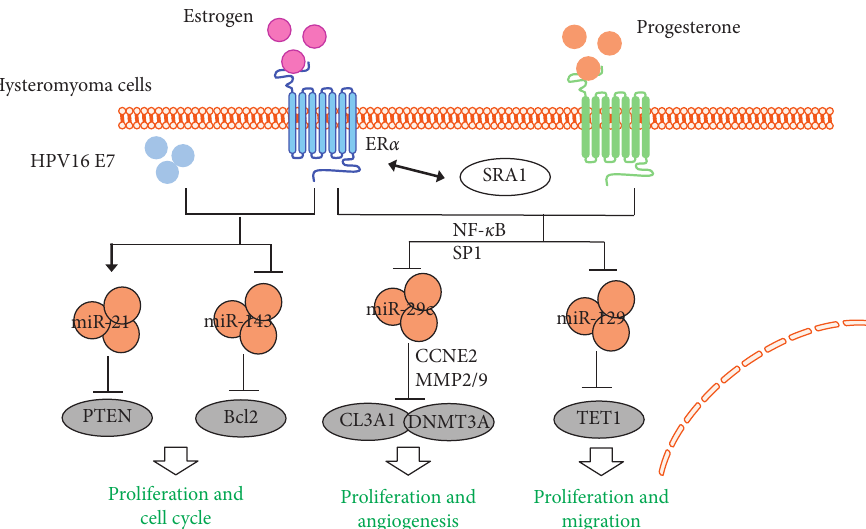
Figure 5: The interaction of ncRNAs and estrogen in hysteromyoma. Several ncRNAs have been reported to interact with estrogen and its receptor in hysteromyoma, including four miRNAs (miR-21, miR-143, miR-29c, and miR129) and a lncRNA SRA1. Solid arrow: induction; flat-ended arrow: